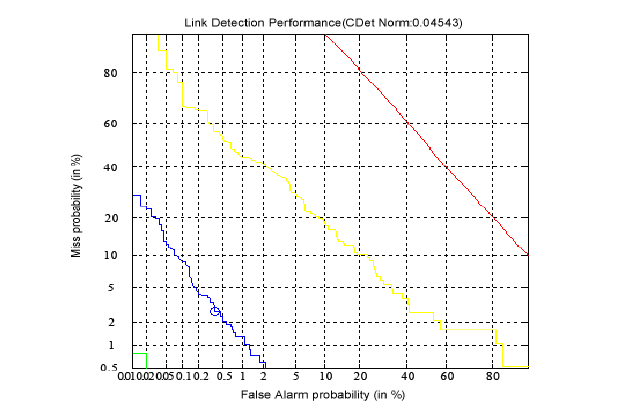
Fig. 3. DET for 310 Stories Covering 32 Topics as Testing Dataset